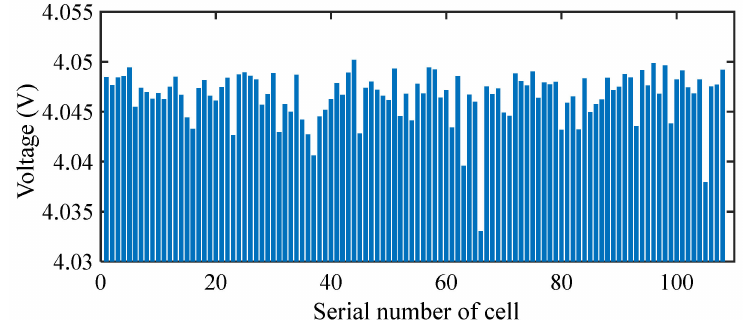
Figure 8. Voltage distribution after excluding internal resistance ( ˆ U k ( 1200 ) ).